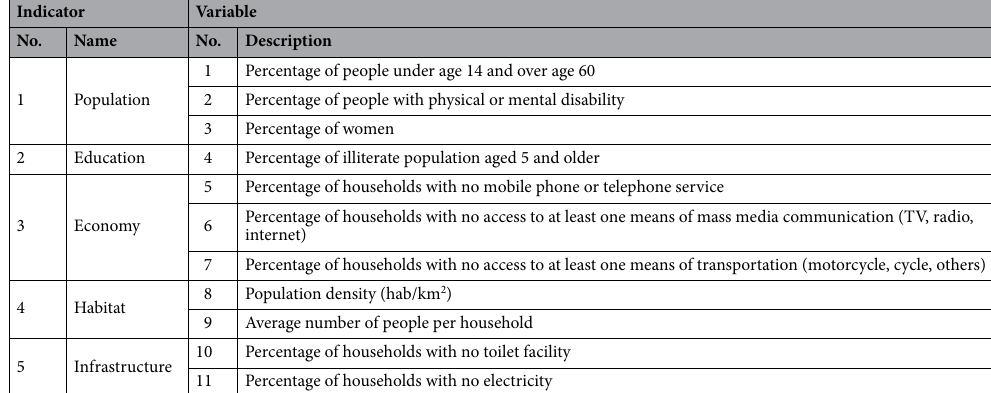
Table 1. Indicators and variables of the Social Vulnerability (SoVI)